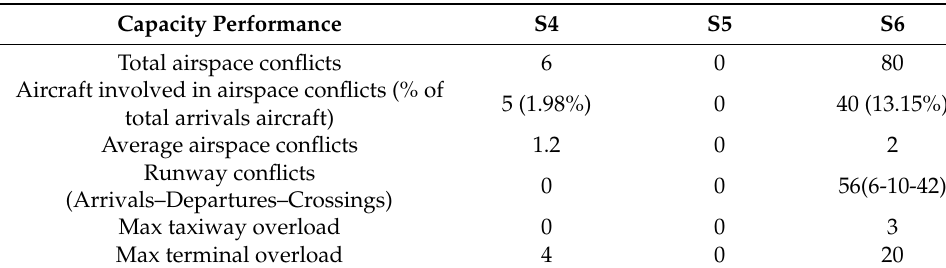
Table 9. Capacity performance for scenarios S4, S5 and S6.